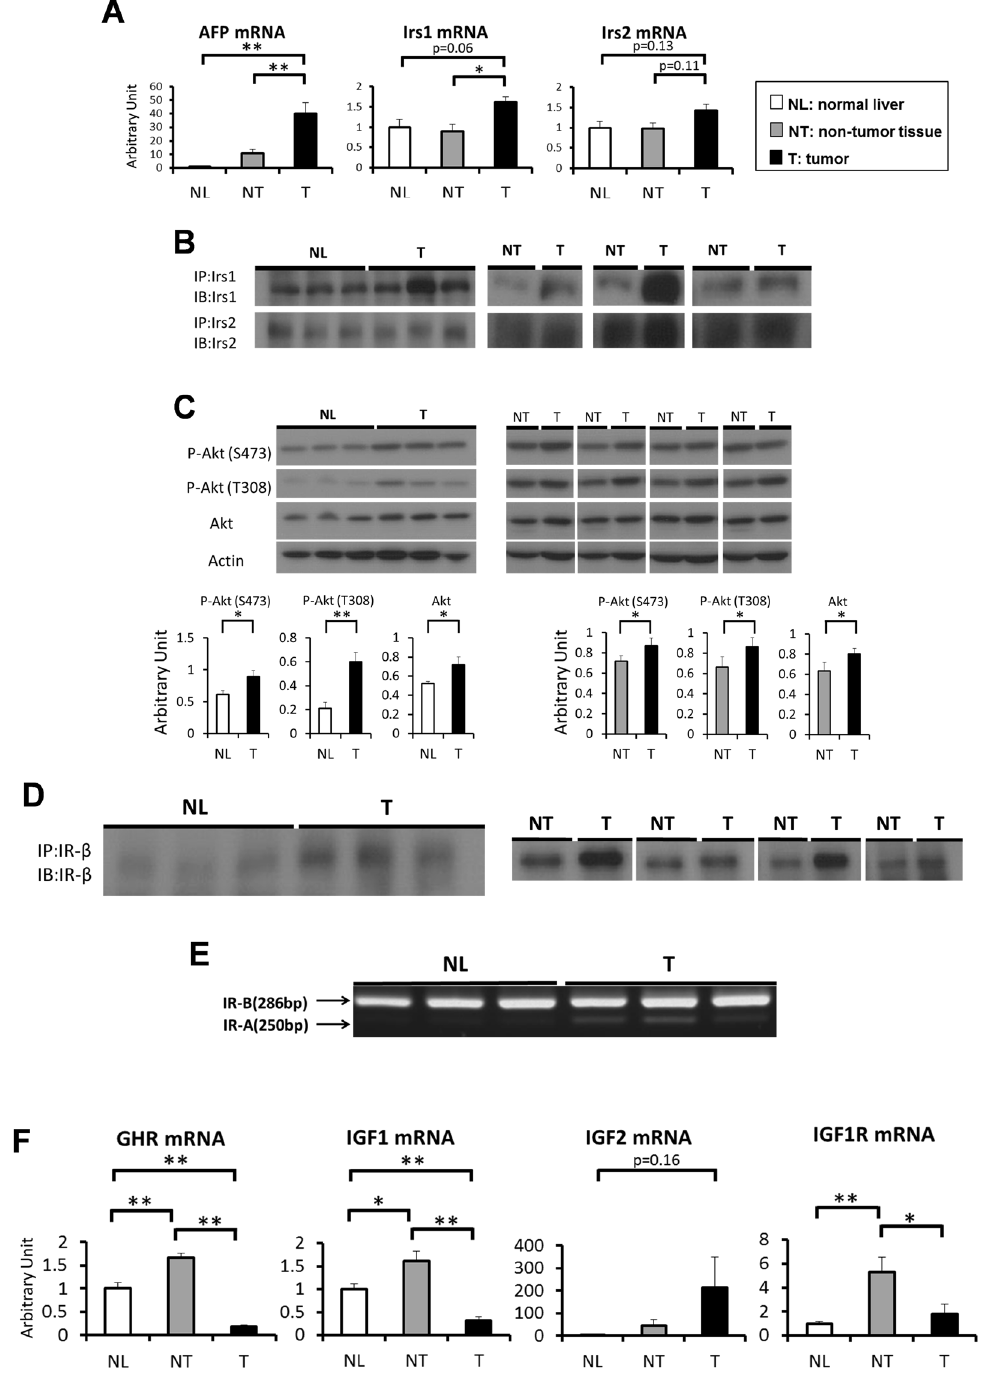
Figure 1. Irs1 is upregulated in DEN-induced HCC. ( A ) Expression levels of AFP, Irs1 and Irs2 genes in each group of mice (n = 7). ( B ) Western blot analysis of Irs1 and Irs2 protein expression levels in NL and T, or NT and T. Lysates from each group were immunoprecipitated (IP) and subsequently immunoblotted (IB) with the indicated antibodies. ( C ) Phosphorylation and protein expression levels of Akt. Representative immunoblot analysis for Akt and p-Akt (upper panel). Results were quantified and normalized to Actin (lower panel) in NL and T (n = 8), or NT and T (n = 8, paired t test). ( D ) Protein expression levels of Insulin receptor (IR). Lysates from each group were immunoprecipitated (IP) and subsequently immunoblotted (IB) with the antibody against IR- β . ( E ) The Insulin receptor (IR) isoforms A and B are indicated by an arrow. Total RNA was extracted from each group and cDNA was synthesized. After PCR experiments using primers for the flanking exons 10 and 12, reaction products were resolved on 2% agarose gels. ( F ) Expression levels of GHR, IGF1, IGF2 and IGF1R genes in each group (n = 7). Values are the means ± SEM of data obtained from each group. NL, normal liver tissues; NT, non-tumor tissues; T, tumors. * P < 0.05. ** P <